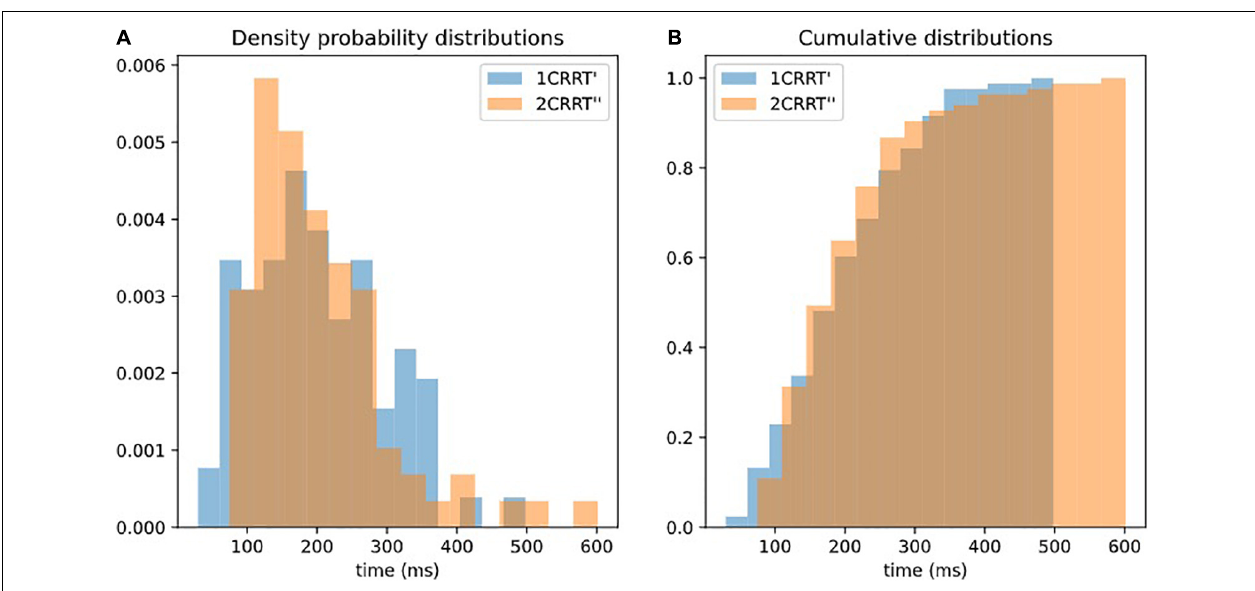
FIGURE 3 | Difficulty scale for reaction times. (A) Arbitrary x -axis positions. The x -axis represents the 3 tasks, and the y -axis the reaction times (in ms). Each line with 3 points represents the reaction times of a subject, and the thick lines represent the average and 1std lines of the 83 subjects. Without a notion of difficulty scale, one could represent arbitrarily the 3 tasks at positions 1,2,3 on the x -axis, as shown in (A) . (B) Difficulty scale x -axis positions. In (B) we represent the 3 tasks, respectively, at positions 0, 1, 1.592, which makes the averages aligned. In other words, we consider that the 0 Choice task has difficulty 0, the 1 Choice task serves as a unit and is at position 1, and the 2 Choices task is 1.592 times more difficult than the 1 Choice task. The average values of 2CRRT (cid:48)(cid:48) and 1CRRT (cid:48) become equal.